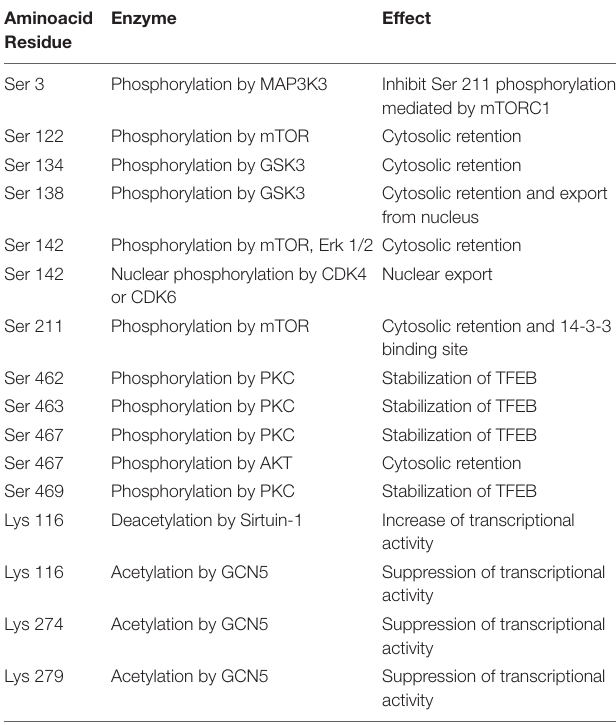
TABLE 1 | Posttranslational modifications of TFEB